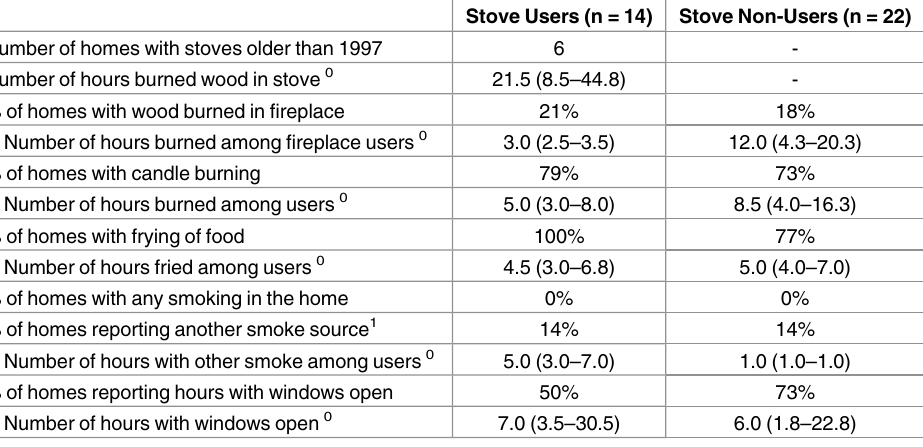
Table 1. Percent of Participating Norwegian Homes (N = 36) With Reporting of Activities that could Generate Particulate Matter and Median Number of Hours Activities were Performed During a 7 Day